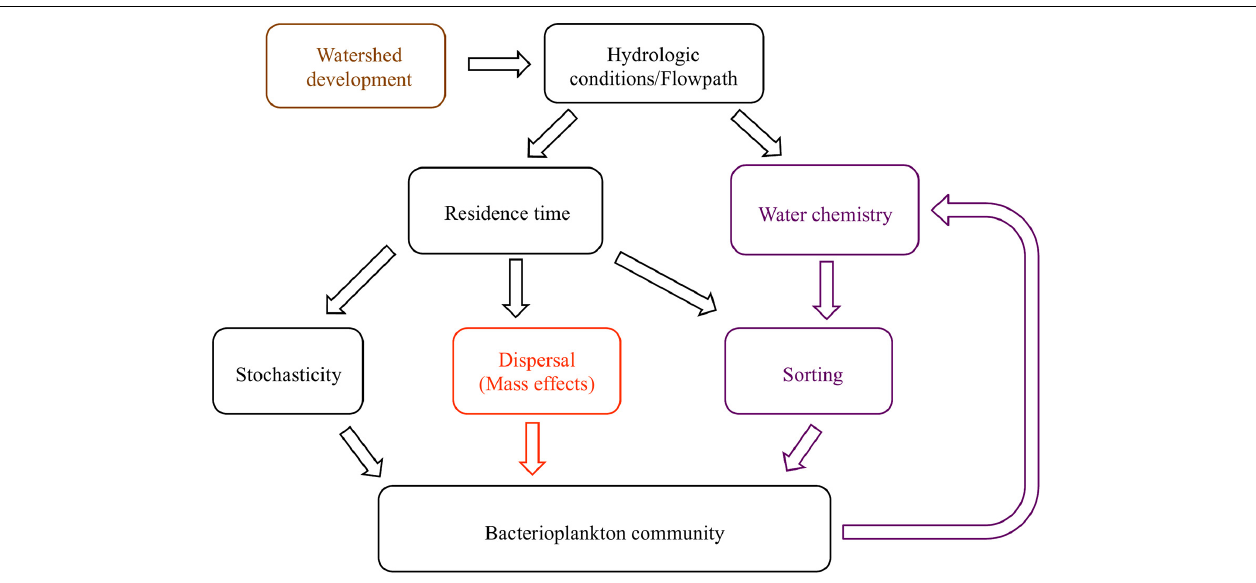
FIGURE 1 | Conceptual diagram of the proposed relationships between hydrologic conditions and bacterioplankton communities. Residence time, a hydrologic condition related to flow velocity and volume, influences the extent that dispersal and stochastic processes alter community composition. Residence time also controls the extent to which environmental pressures act on communities to create species sorting, or selection. When dispersal is high, mass effects dominate; otherwise, dispersal limitation may occur. Bacterial metabolic activity affects water chemistry, creating a feedback loop within the model (hypothesis 1, purple). The community composition similarity along and between watersheds is related to longitudinal and lateral dispersal (hypothesis 2, orange). Anthropogenic changes to watersheds affect hydrologic conditions, and with repercussions on all aspects of the system (hypothesis 3,